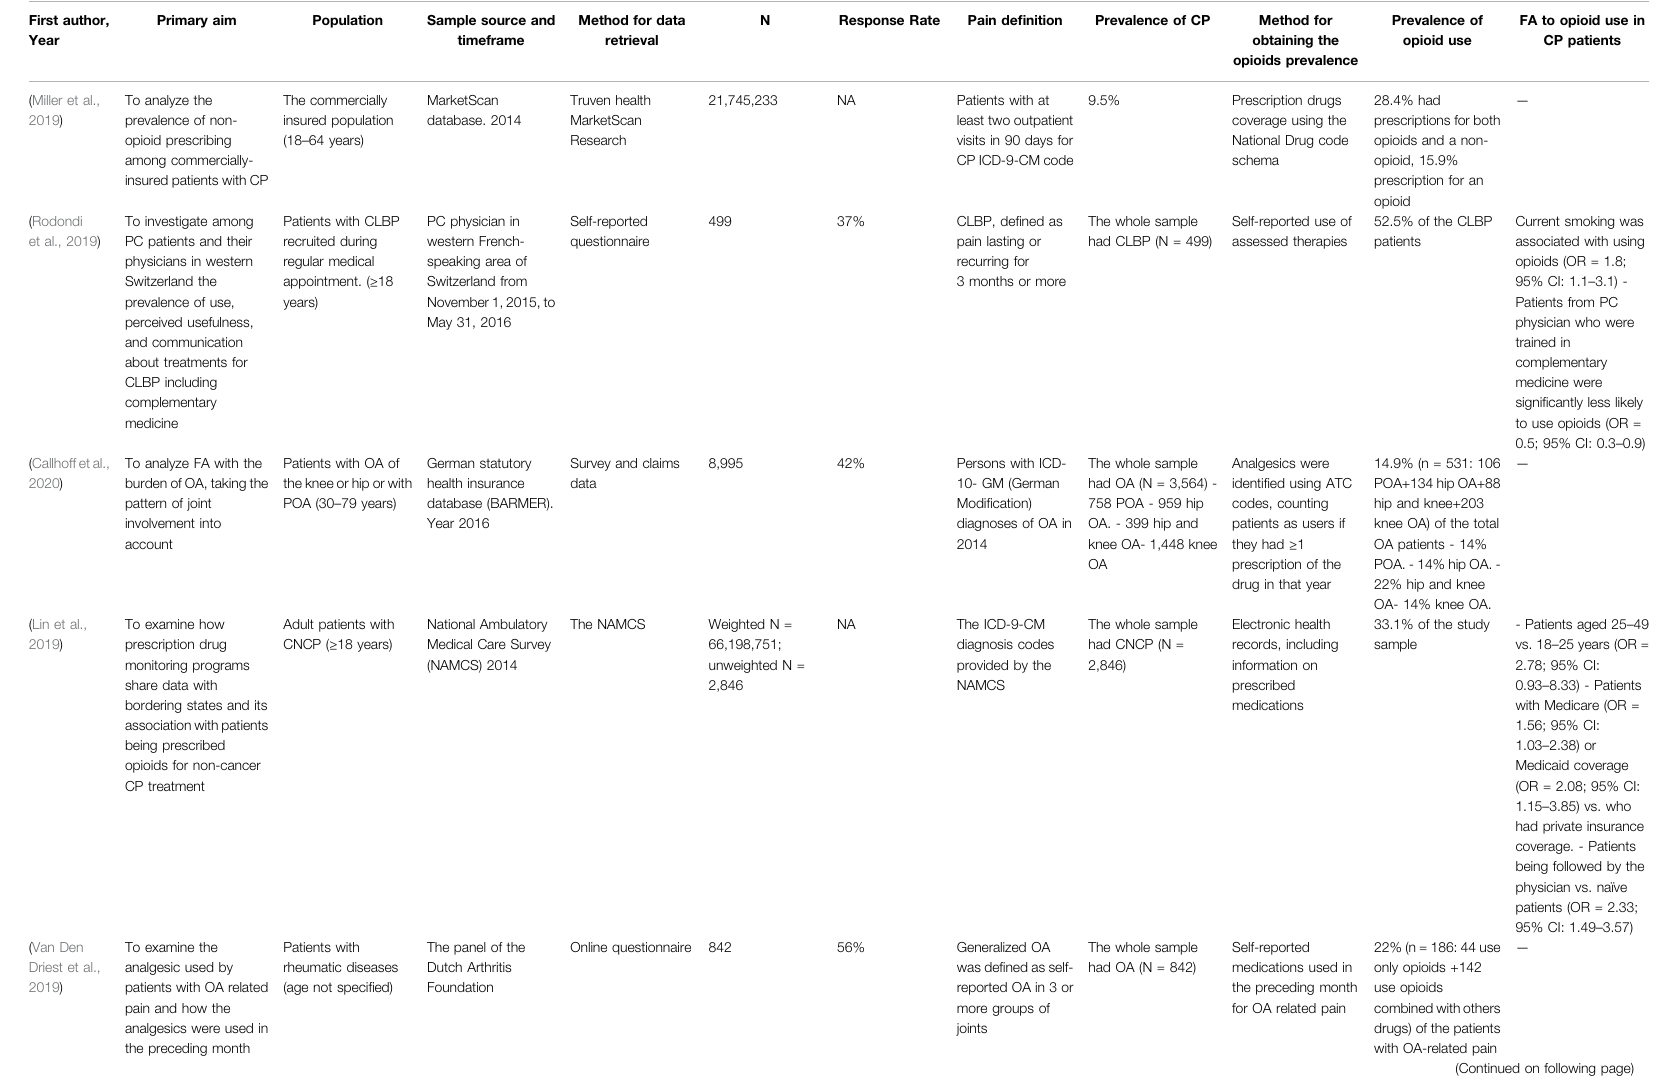
TABLE 2 | Characteristics of the studies included in the systematic